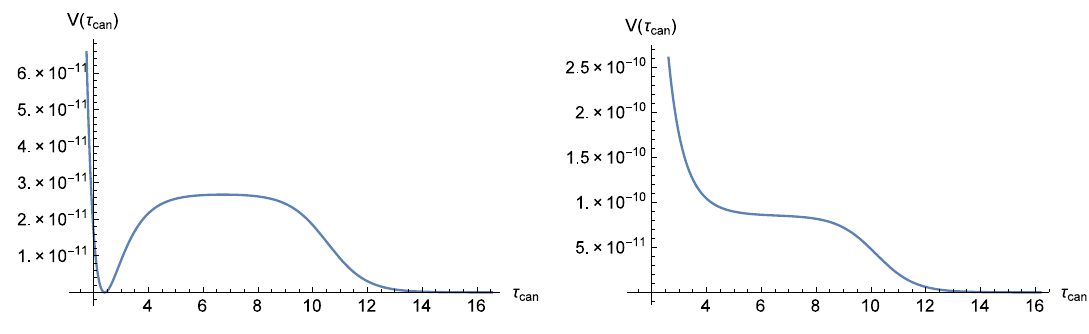
Figure 1 . The scalar potentials for A > 0 (left) and A < 0 (right) are shown.